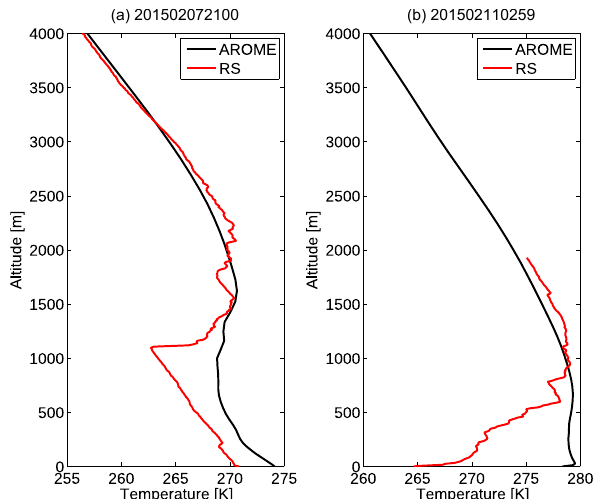
Figure 4. Temperature profiles observed by the radiosonde (red line) or extracted from the AROME analyses (black line): during unstable conditions 7 February at 21:00UTC (a) and during the most stable period 11 February at 03:00UTC (b) . Altitudes are given in meters above ground